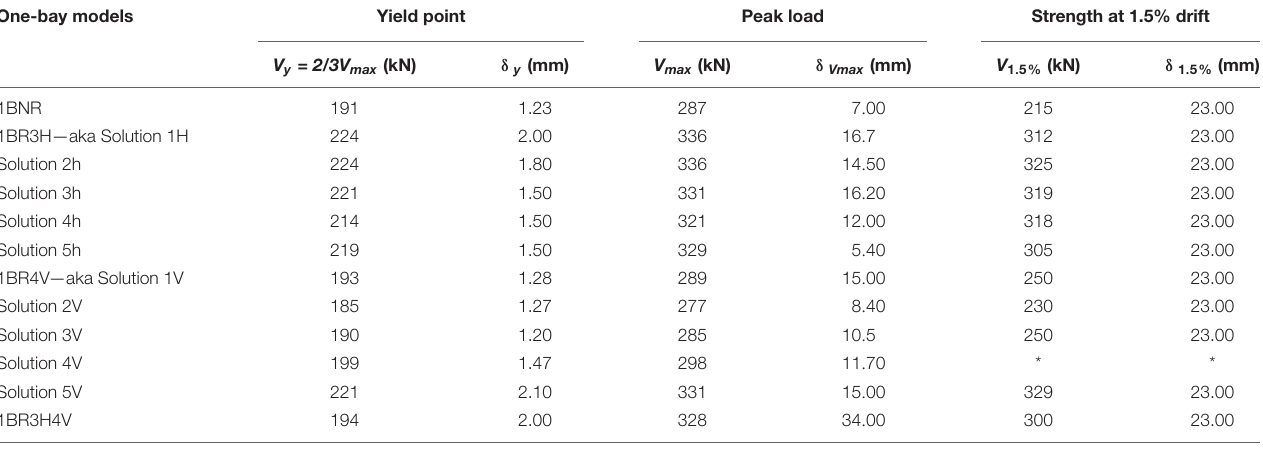
TABLE 3 | Numerical results of non-retrofitted (NR) and retrofitted specimens (one-bay frame). One-bay models